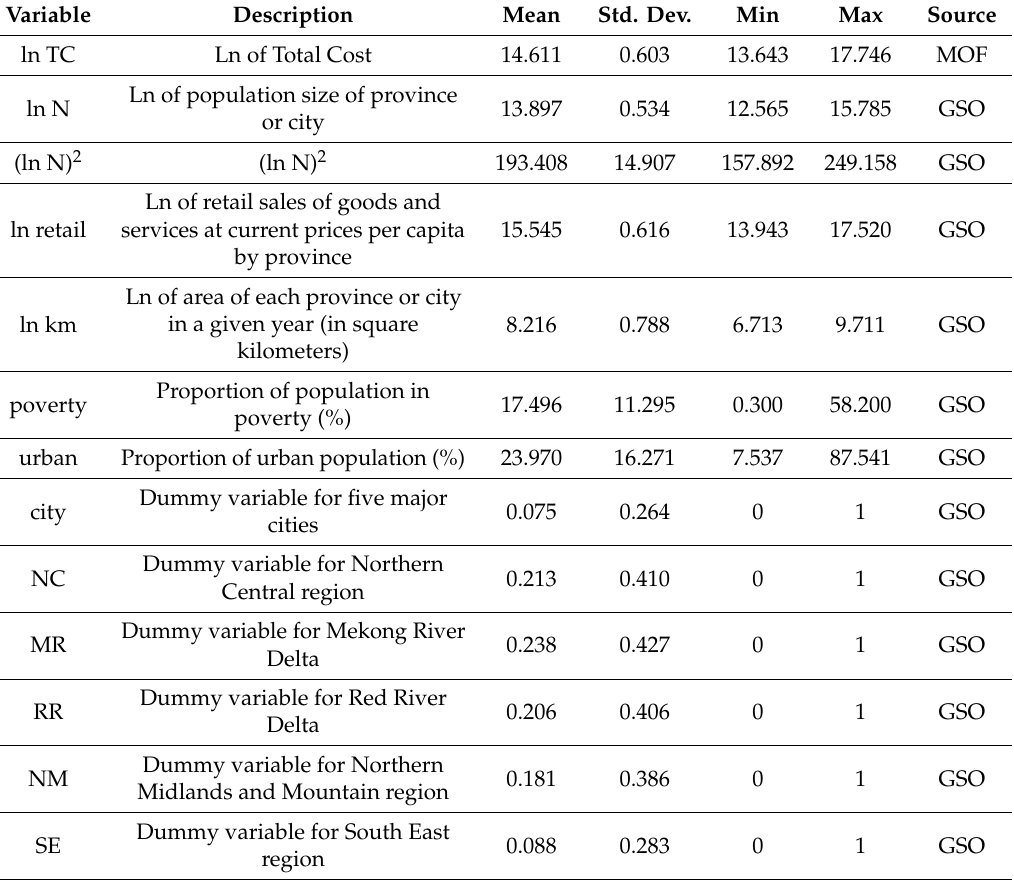
Table 1. Descriptive